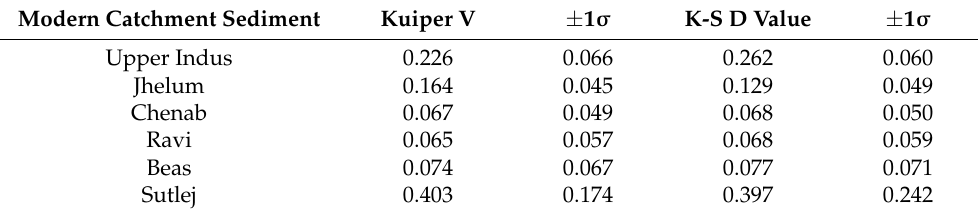
Table 2. Modern catchment sediment analysis of five river